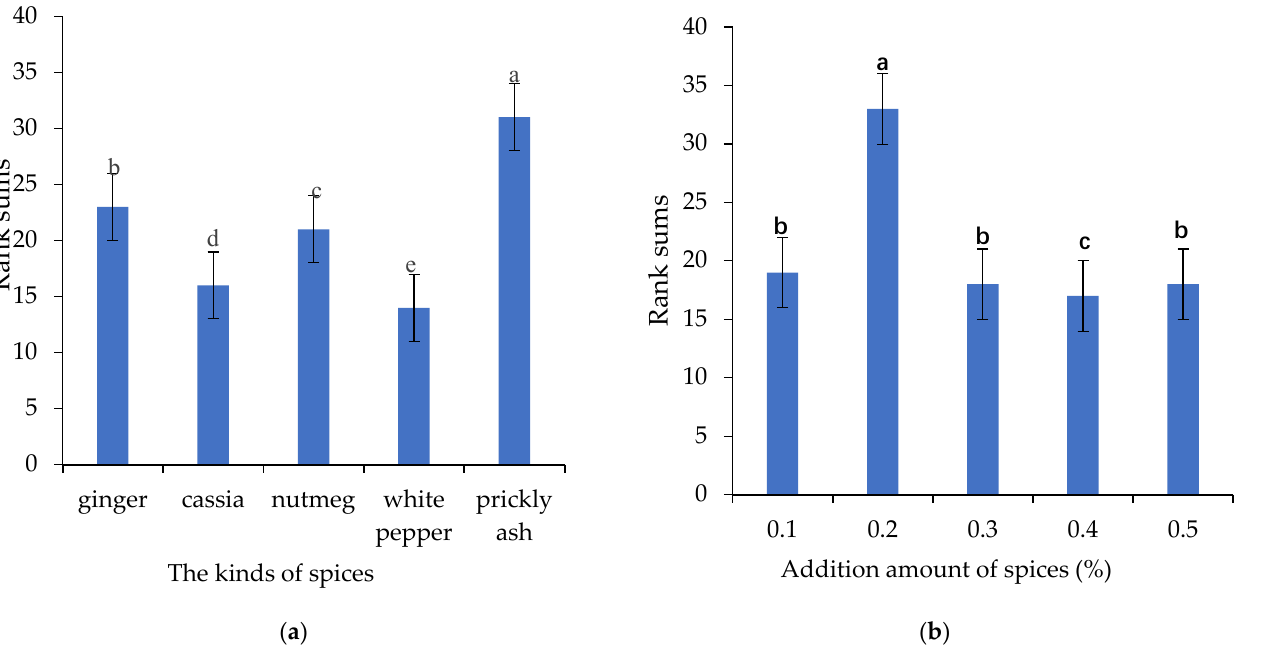
Figure 1. Results of spices selection and addition (( a ) rank sums of five spice varieties; ( b ) rank sums of addition ratio from 0.1 to 0.5%). Letters (a, b, c) indicate significantly difference at p < 0.05 (Duncan